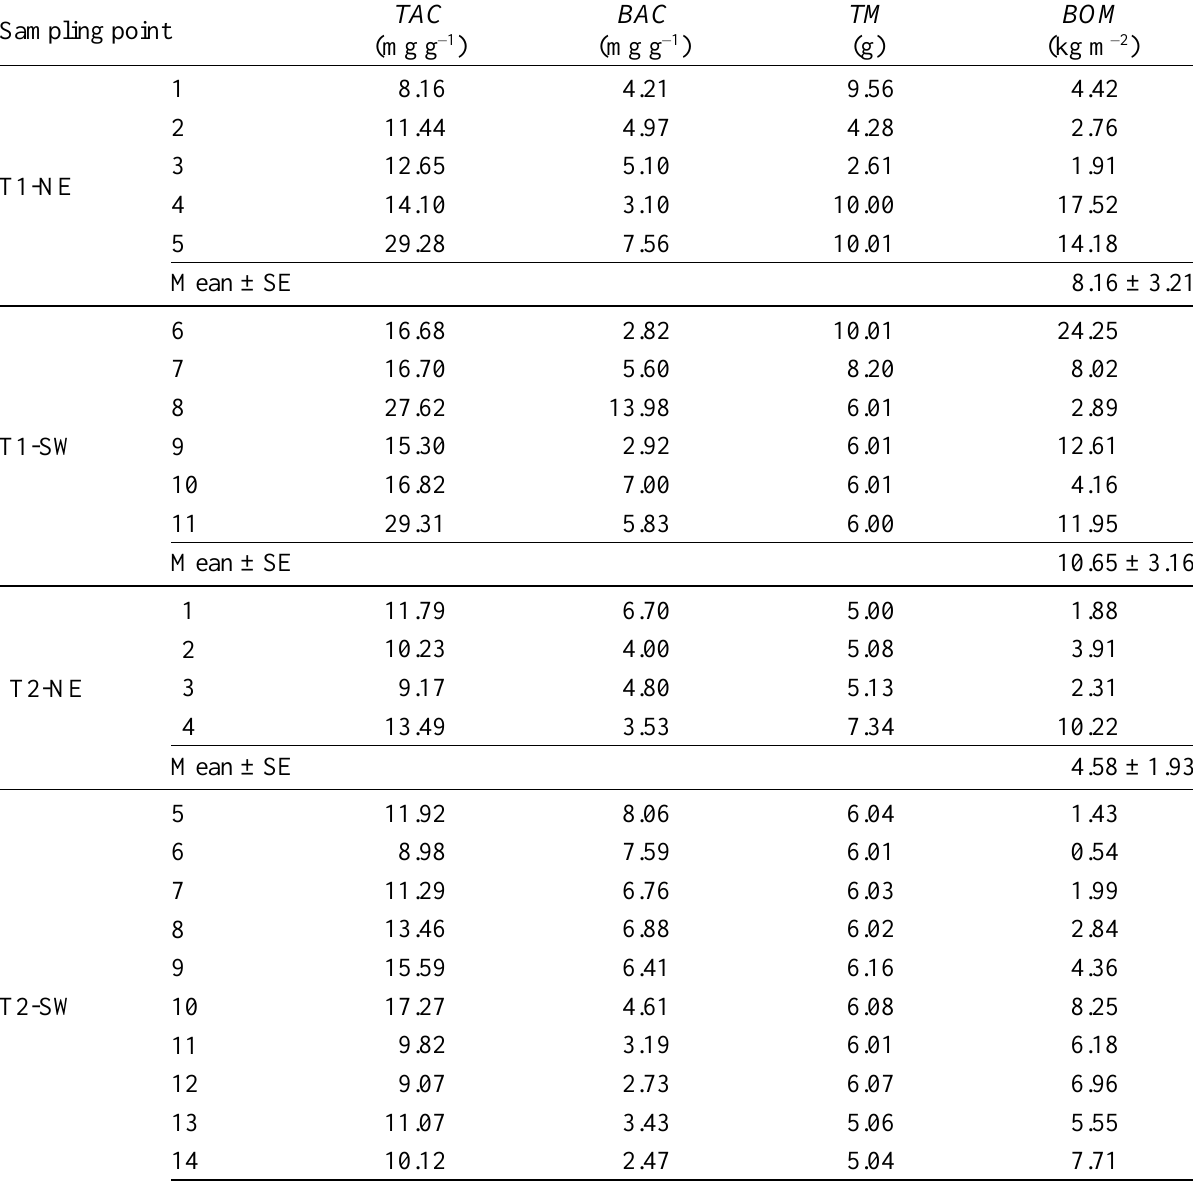
Table 2. TAC - Top Ash Content, BAC - Bottom Ash Content, TM - Top Mass, BOM - Burned Organic Matter, SE - Standard